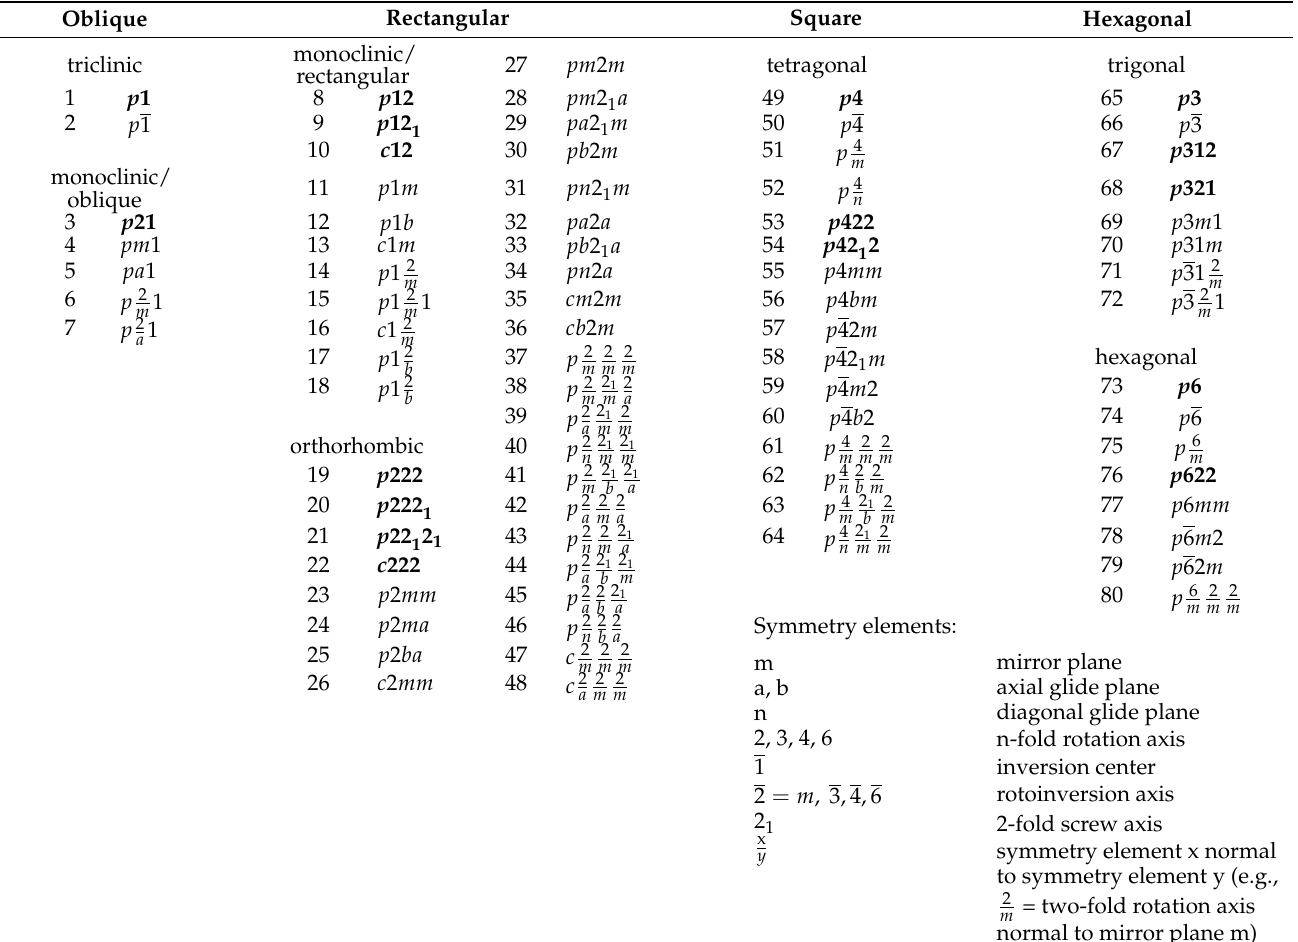
Table A1. The 80 two-sided plane groups (2D-space groups) and their lattice